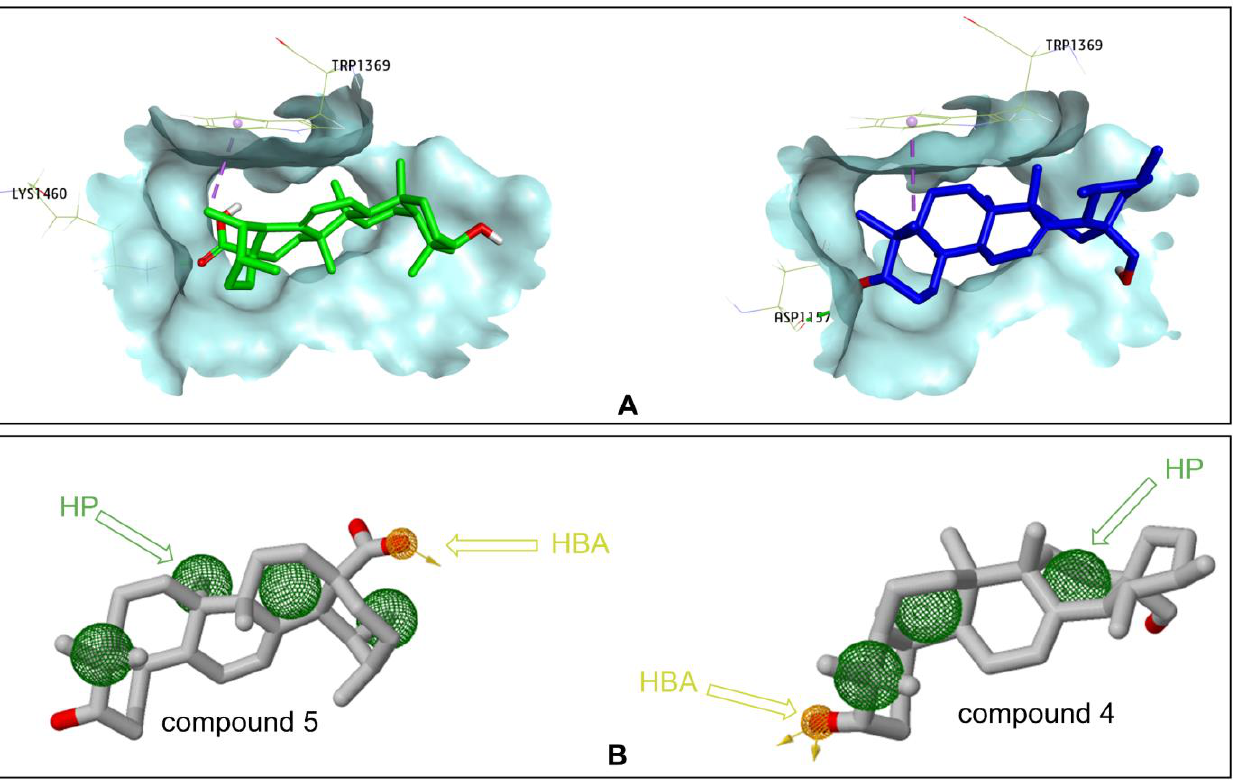
Figure 6. ( A ) Compound 4 (blue) and Compound 5 (green) in the binding site of human intestinal α -glucosidase; ( B ) pharmacophore model. HBA: Hydrogen bond acceptors are depicted as yellow- brown arrows; HP: hydrophobic areas are depicted as green spheres.